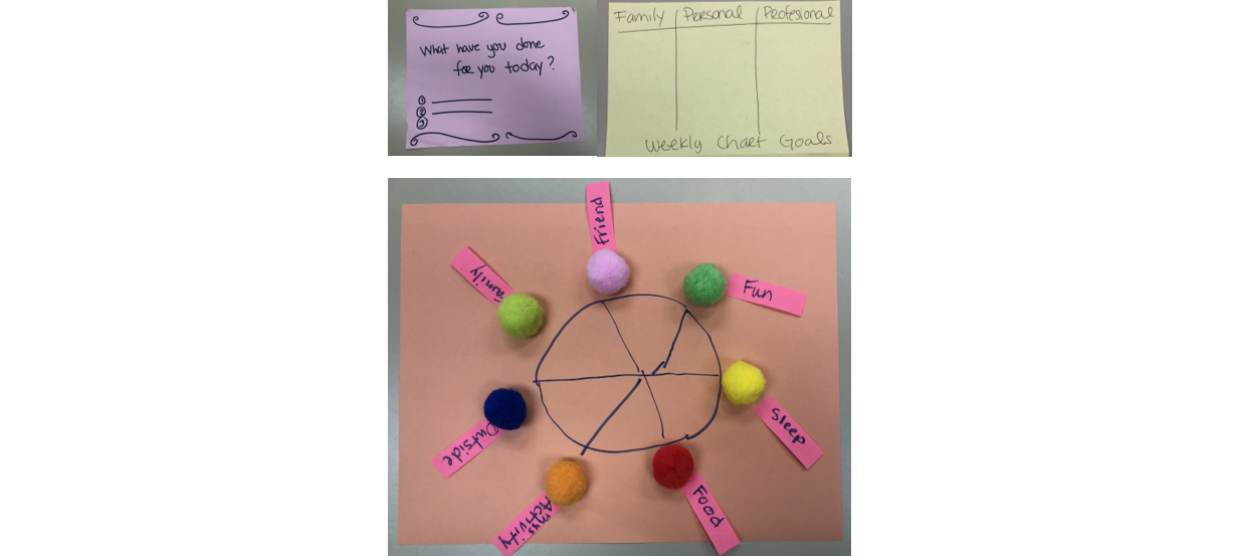
Figure 3. Example design artifacts from non-Latino parents. From left to right, top to bottom: reminder for self-care, setting weekly goals, and pie chart for self-care